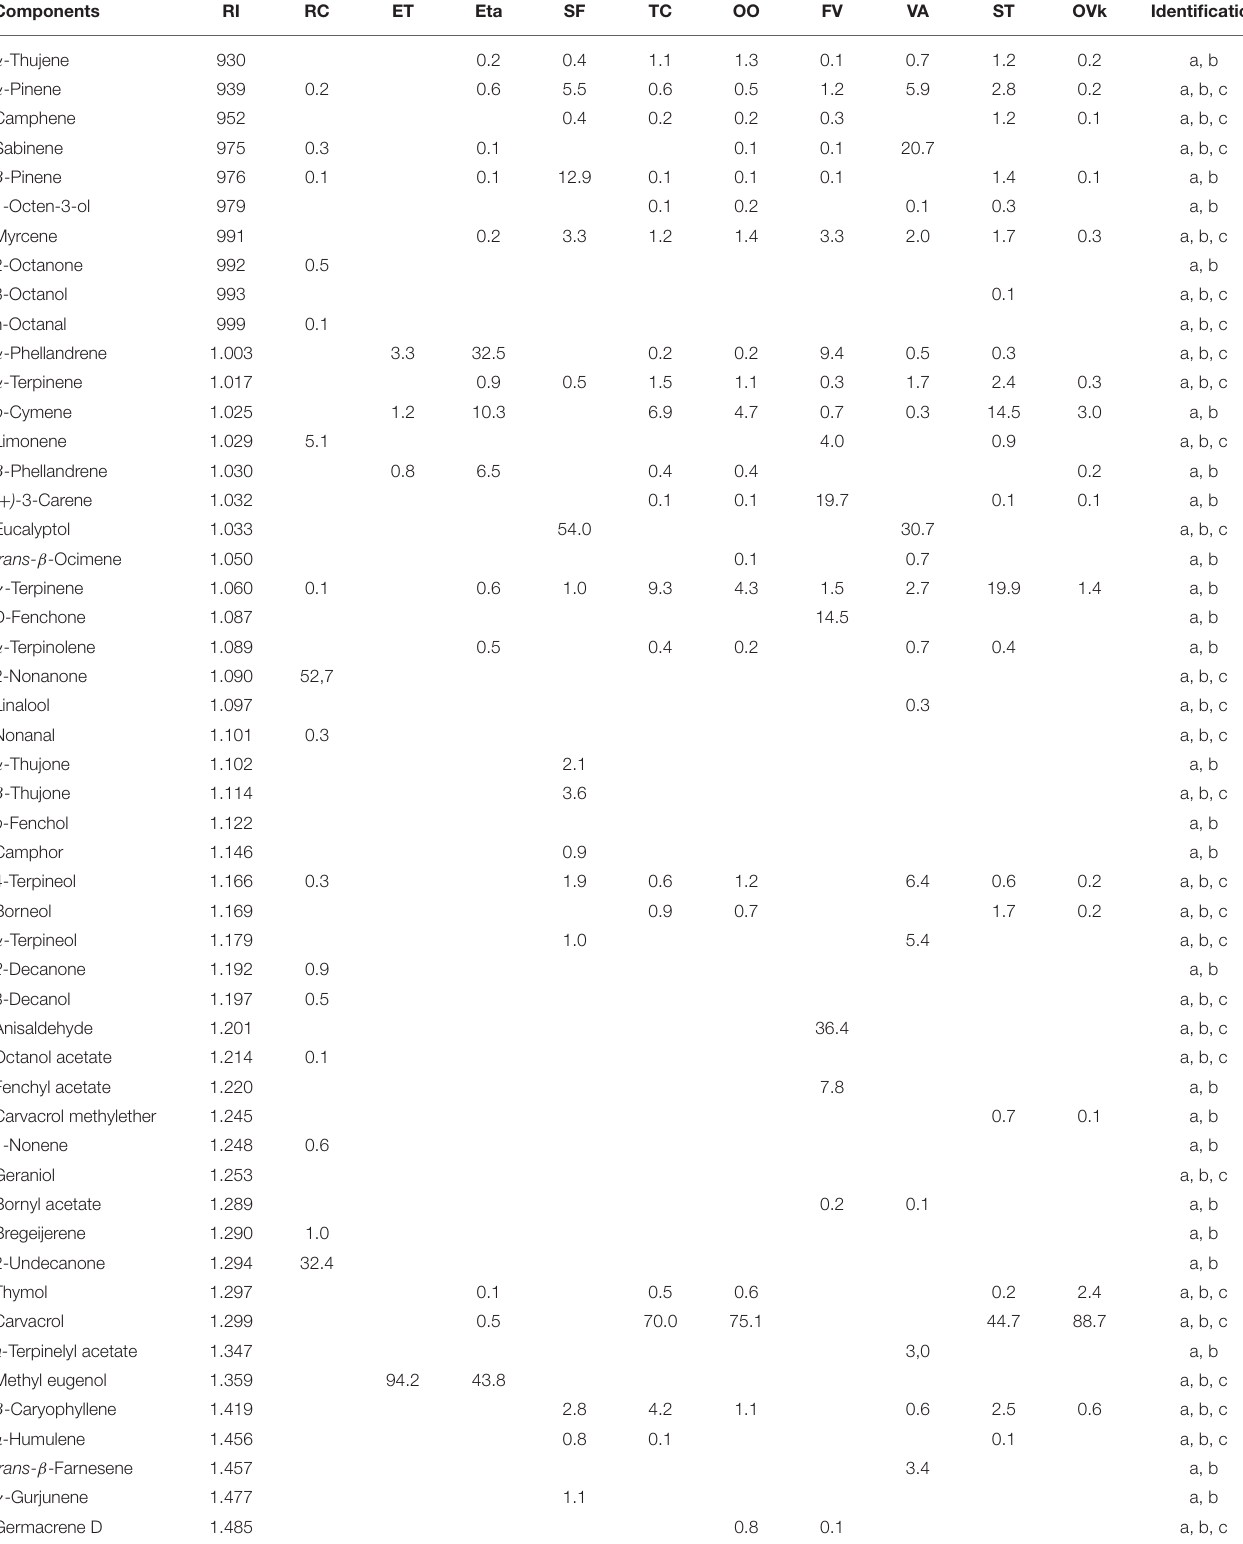
TABLE 2 | Essential oils